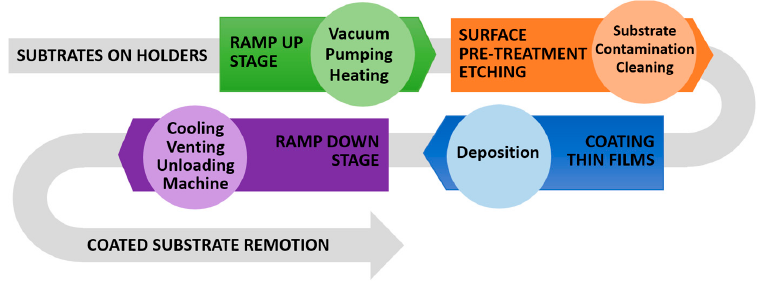
Figure 3. The processing flow for a classic PVD sputtering process.